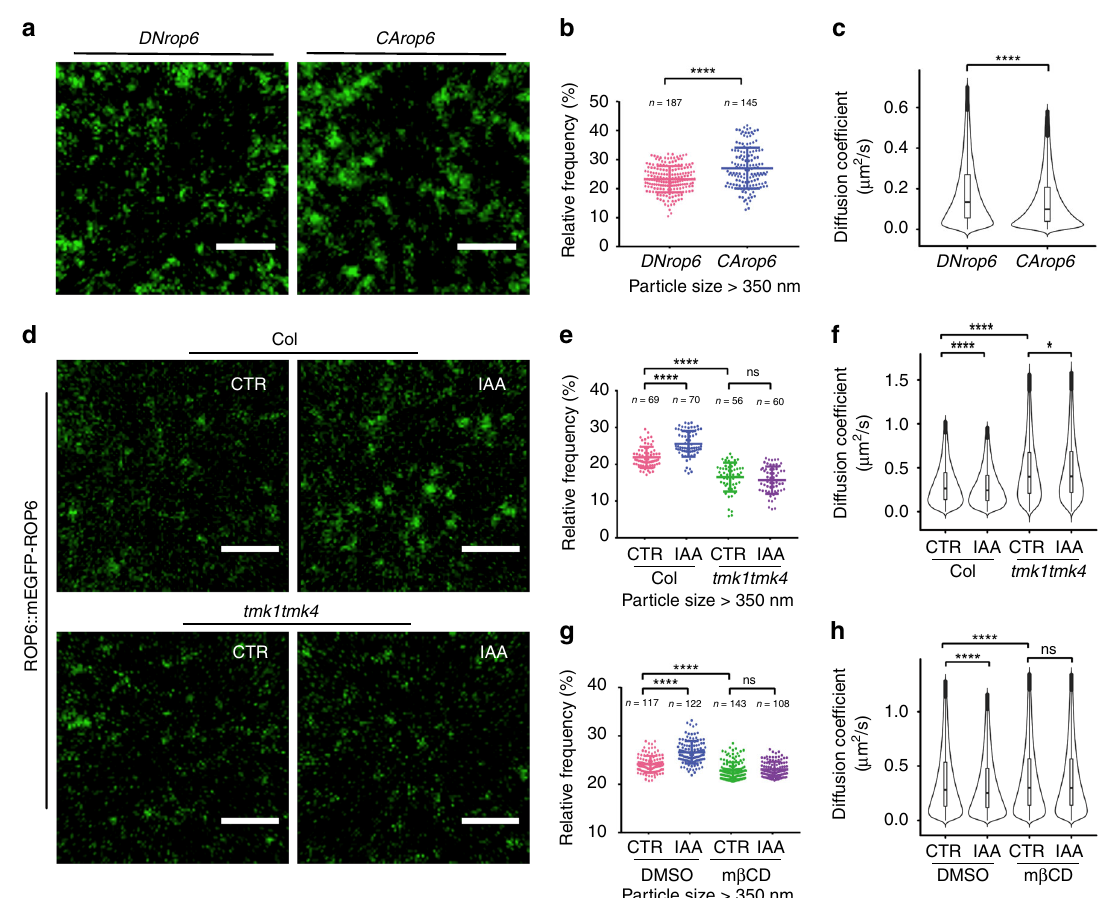
Fig. 5 TMK contributes to the auxin-promoted nanoclustering and stabilization of ROP6 particles. a – c CArop6 formed larger particles with slower diffusion rate than DNrop6 at the plasma membrane. a Representative TIRF images of pavement cells (PCs) expressing 35S::YFP- CArop6 and 35S::YFP- DNrop6 . b Relative frequency of YFP- CArop6 and YFP- DNrop6 particles with size larger than 350 nm. c Diffusion coef fi cients of YFP- CArop6 and YFP- DNrop6 particles. The number of particles analyzed for YFP- DNrop6 and YFP- CArop6 lines are 97,390 and 86,712, respectively. d – f Auxin-induced increase in size and decrease in diffusion rate of ROP6 particles was compromised in the tmk1tmk4 double mutant. d Representative TIRF images of PCs expressing ROP6::mEGFP-ROP6 in wild type (Col-0) and tmk1tmk4 mutant treated with or without IAA (100 nM, 10 min). e Relative frequency of ROP6 particles with size larger than 350 nm. f Comparison of diffusion coef fi cients of ROP6 particles in different treatments. The number of particles analyzed in each treatment (from left to right) are 40,685, 42,016, 32,663, and 32,893, respectively. g , h Auxin-induced increase in size and decrease in diffusion rate of ROP6 particles was abolished in the presence of the sterol-depleting agent methyl- β -cyclodextrin (m β CD). g Relative frequency of ROP6 particles with size larger than 350 nm in control and IAA-treated cells with or without m β CD pretreatment. h Comparison of diffusion coef fi cients of ROP6 particles in different treatments. The number of particles analyzed in each treatment (from left to right) are 354,303, 355,561, 458,949, and 411,675, respectively. CTR, control. Data in b , e , g are presented as mean ± SD, and n represents the number of independent cells. All data are representative of three independent experiments with the same pattern. Scale bars = 2 μ m. * P < 0.05, **** P ≤ 0.0001; ns, not signi fi (Fig. 6d – f). In addition, TMK1 and fl otillin1 particles displayed largest particle sizes and slowest diffusion rates in the presence of auxin and intact CMTs, and depolymerizing CMTs did not completely block the auxin-induced diffusion decrease (Fig. 6a – f), suggesting that the stabilization of TMK1 and fl otillin1 particles is regulated by auxin-induced nanoclustering and the subsequent CMT-mediated diffusion restriction. To complement the phar- macological approach, we further studied the dynamics of TMK1 and fl otillin1 particles in the ktn1 mutant, which has altered microtubule organization and PC shape 27 . As shown in Supple- mentary Fig. 9A – D, the particles of TMK1 and fl otillin1 displayed smaller size and faster diffusion rate in the ktn1 mutant than in the wild type. In addition, the dynamics of TMK1 particles were studied in the temperature-sensitive mor1-1 mutant, in which CMTs become shortened and disorganized when grown at the restrictive temperature (29 °C) for 2 h 51 . The diffusion rate of